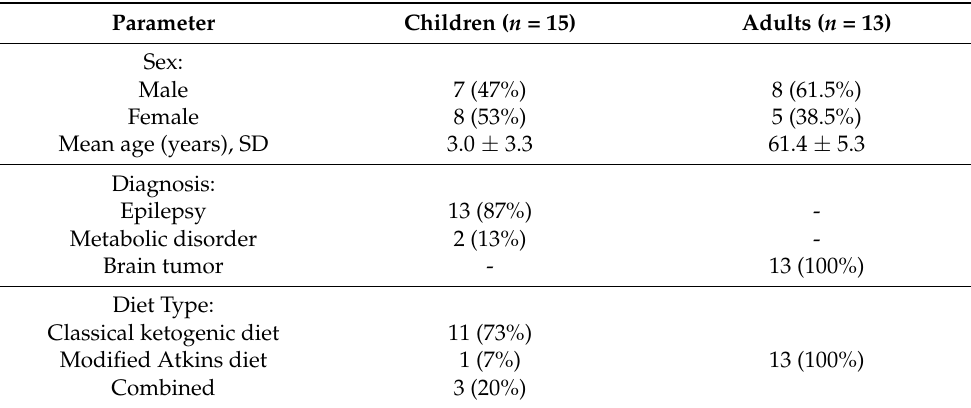
Table 1. Baseline demographics of